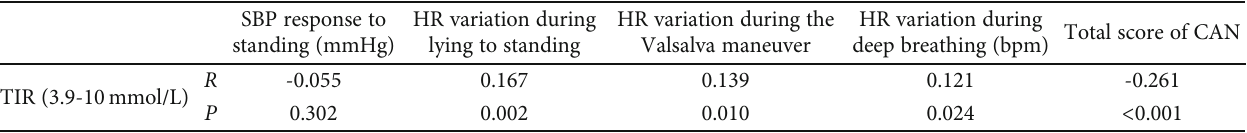
Figure 2: Prevalence of CAN in di ff erent quartiles (Q1-Q4) of TIR. a CAN: cardiovascular autonomic neuropathy; b TIR Q1 ≤ 41 %, Q2: 41-64%, Q3: 64-83%, Q4 > 83 %. c As shown in this fi gure, patients were divided into groups according to quartiles of the time in range (TIR), the proportion of de fi nite CAN decreased with the increase of TIR, while a similar decreased was found between the prevalence of severe CAN and quartiles of TIR ( P < 0 : 05 ). P value for the signi fi cant di ff erence among the groups was determined by χ 2 -test. Table 3: The correlation of TIR and parameters of